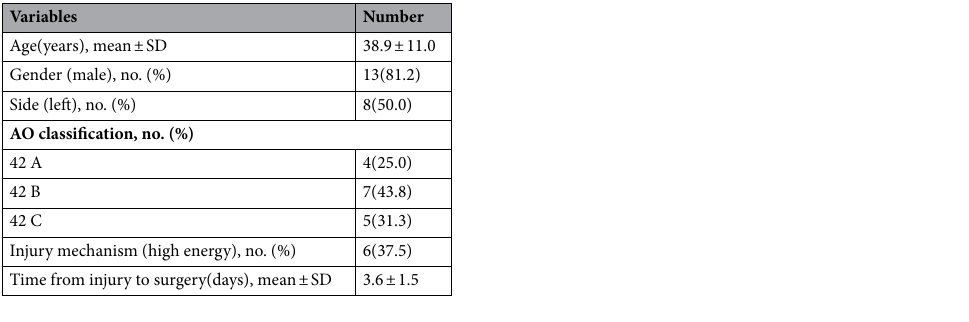
Table 1. Patient demographic data and fracture characteristics. SD standard